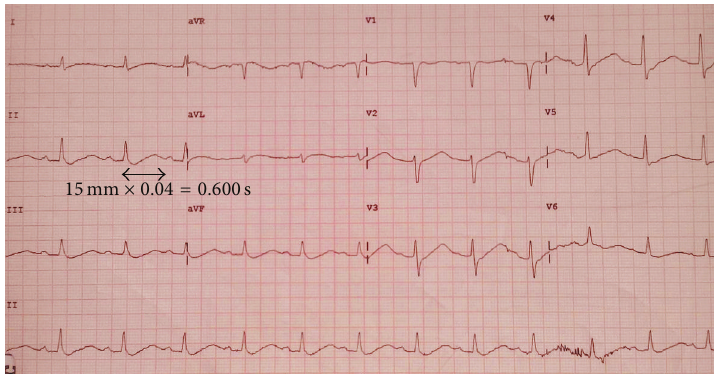
Figure 1: Electrocardiogram on admission shows sinus rhythm, mild increase in P waves, and mild depression of the ST segment. Note the prolonged QT interval of 600 milliseconds.